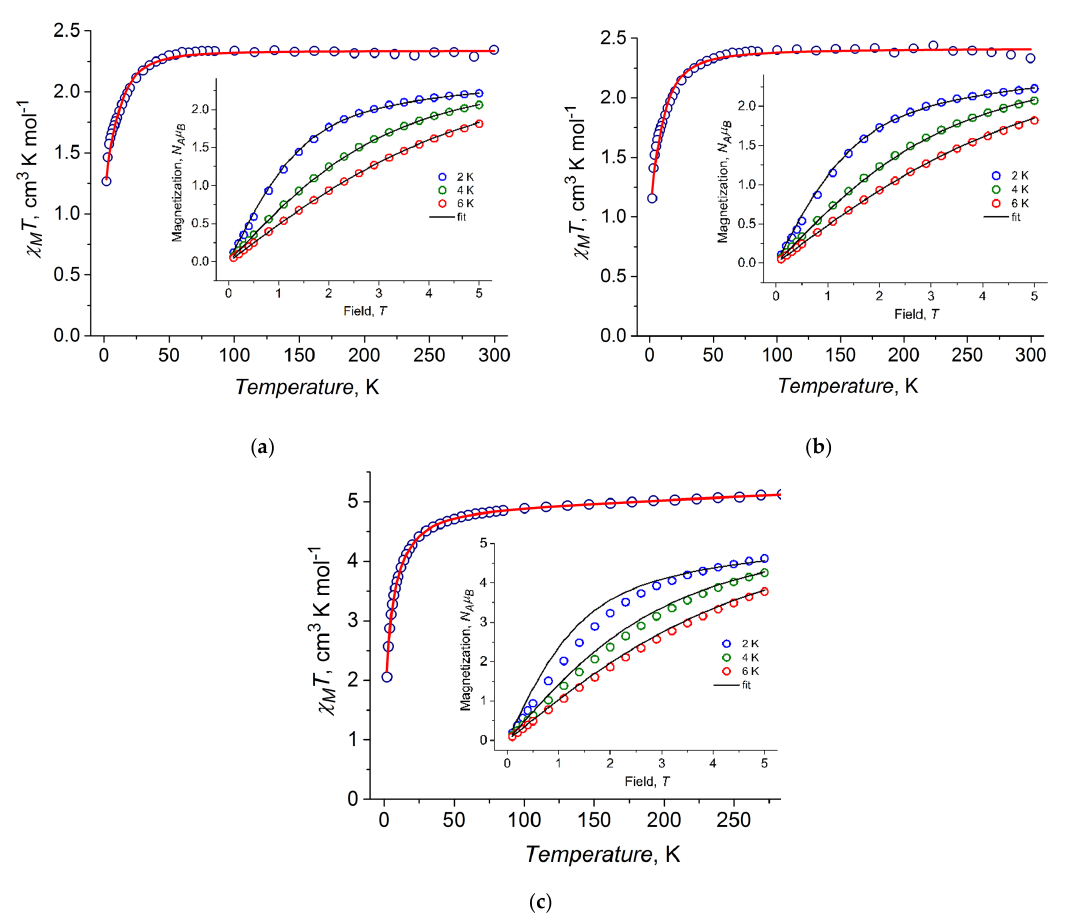
Figure 9. Temperature dependence of χ M T for 1 ( a ), 2 ( b ), and 2a ( c ) recorded at H = 5000 Oe (open circles). Insert: Magnetization vs. field for 1 , 2 , and 2a measured at T = 2, 4, and 6 K. Theoretical curves (solid lines) are calculated within the best-fit parameters listed in Table 5.